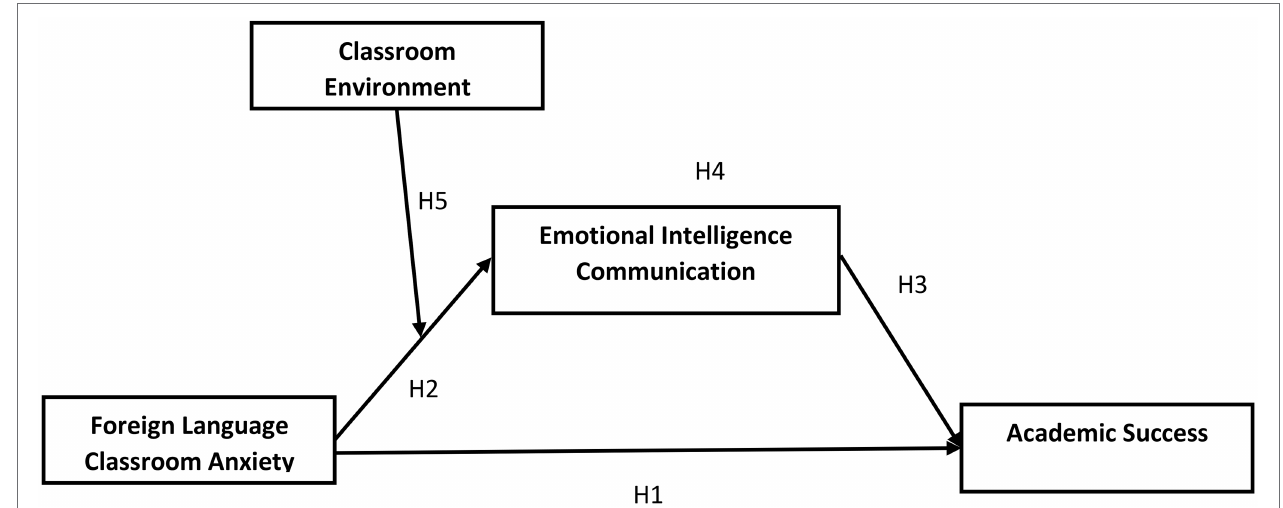
FIGURE 1 | Research